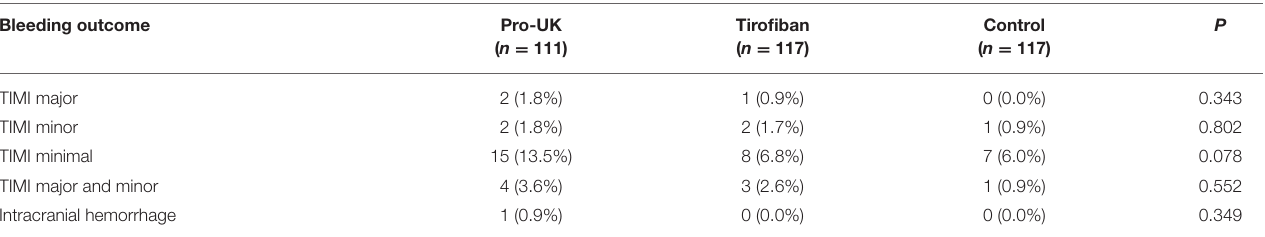
TABLE 4 | Safety outcomes in-hospital bleeding outcomes. Bleeding